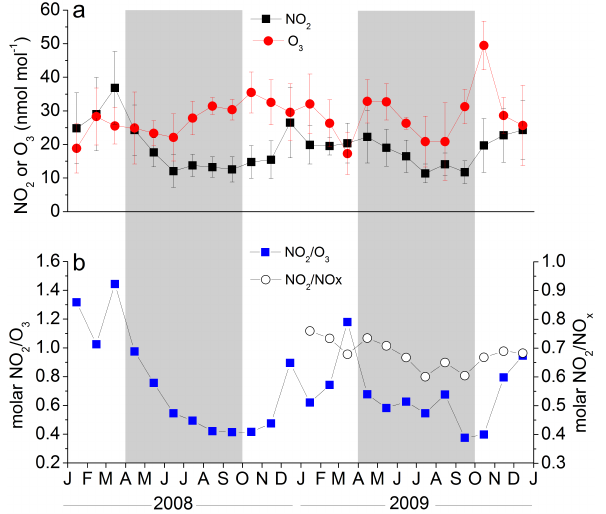
Fig. 5. Seasonal changes in NO 2 and O 3 concentrations (a) , monthly mean of three monitoring sites), molar ratios of NO 2 /O 3 and NO 2 /NO x (b) during the study course in Guangzhou City. The shaded areas denote the warm seasons from April to September. Data is available at: http://www-app.gdepb.gov.cn/EQPublish/raqi. aspx).